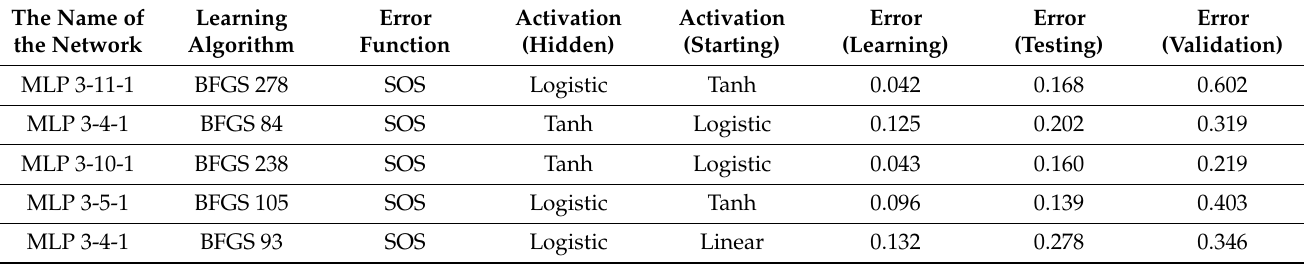
Table 4. The results of ANN modeling for the energy stored in the PCM battery determined on the basis of the electric energy supplied to the battery, temperature inside the object, paraffin